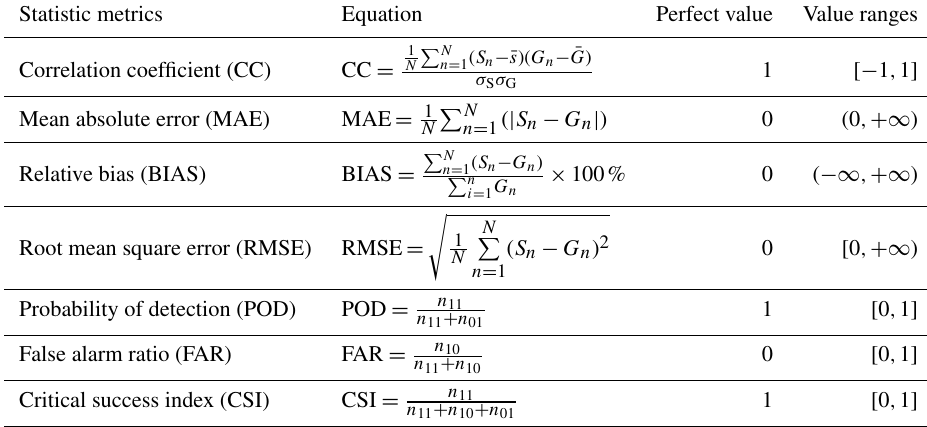
Table 2. Formulas and perfect values of the evaluation metrics used in this